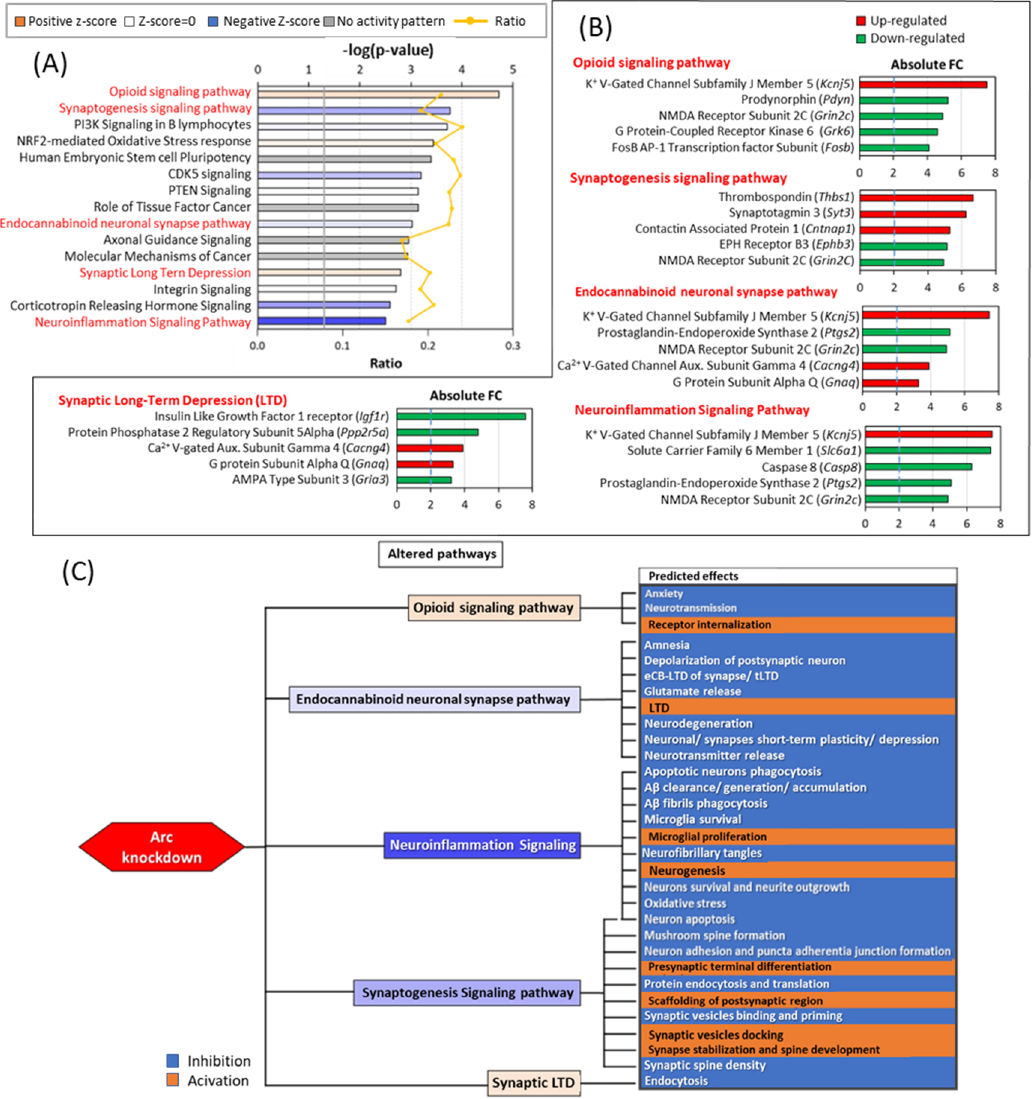
Figure 11. Pathways altered by Arc knockdown. ( A ) Bar chart showing altered pathways identified by IPA. The orange line graph indicates the ratio of genes that were involved in the specified pathway. The grey line indicates threshold at p -value 0.05. The orange and blue bars indicate predicted activation and inhibition of pathways, respectively (determined by z-score). ( B) Top 15 significantly altered pathways are shown. Pathways with predicted activation or inhibition of downstream effects are in red, further elaborated in panel C. The top 5 genes altered in the respective pathways are shown on the right and bottom of the alter ed pathway bar chart. ( C ) Diagram describing the predicted effects of the altered pathways. Five pathways are highlighted, and the downstream effects as predicted by IPA are listed.